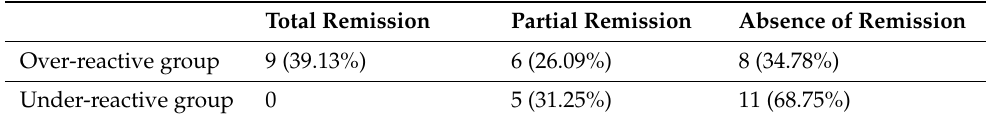
Table 2. Outcome (over-reactive vs. under-reactive groups). Total Remission Over-reactive group